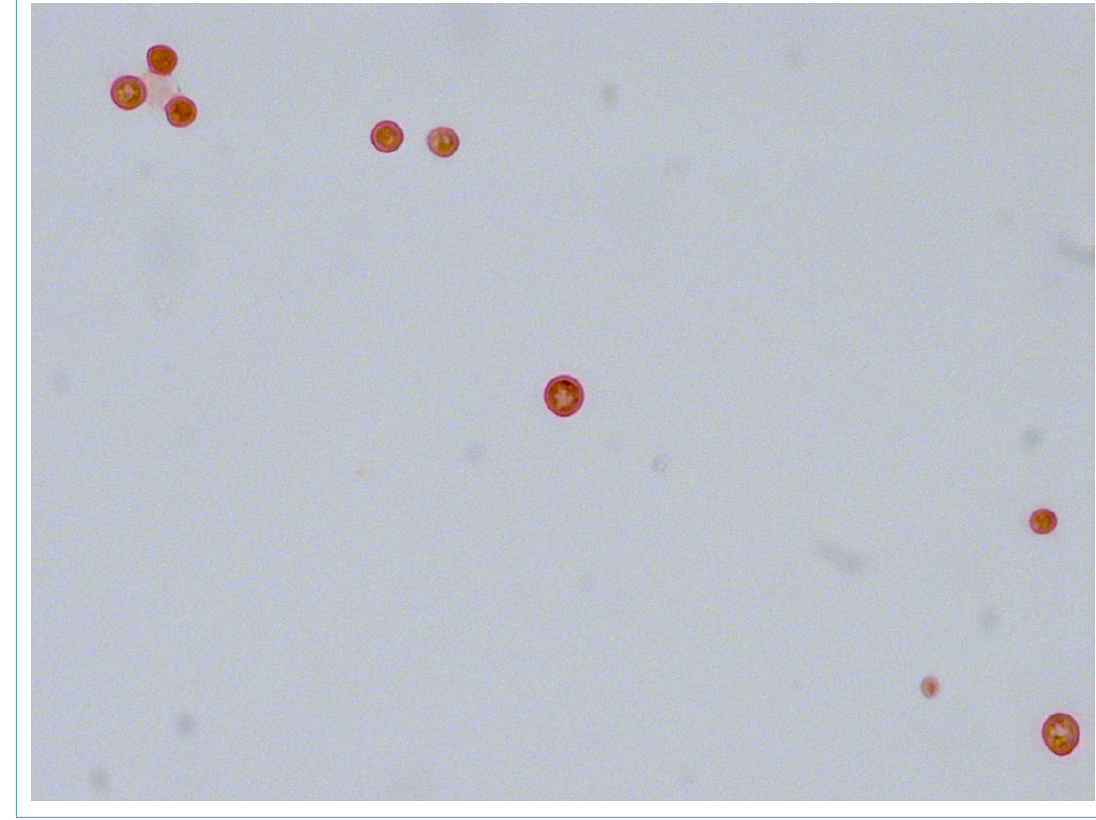
Figure 3: Mucicarmine stain of broncho-alveolar lavage fluid (magnification 63×) confirmed a cryptococcal infection, by highlighting the yeast’s characteristic large